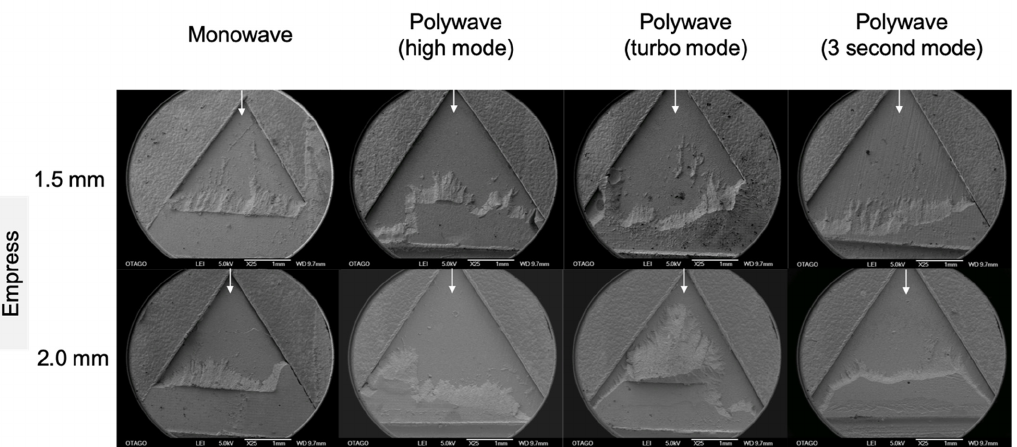
Figure 6. SEM images of bonded specimens between Empress and resin cement at 25 × magnification to show overall mode of failure. The arrow is positioned at the tip of the chevron notch and shows the direction of crack propagation.